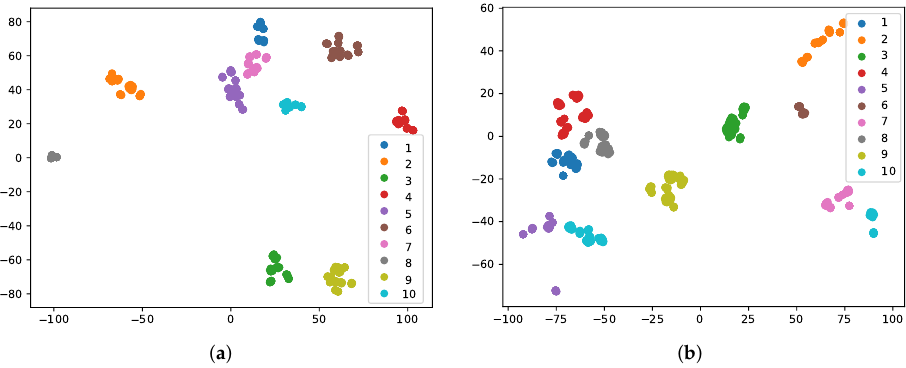
Figure 7. The t-SNE visualization for the features ( a ) proposed method features and ( b ) “GEI + ResNet50TP + L2” features on the testing set. Each color represents an identity and the features of every person are extracted from samples under “BG”, “CL”, and “NM” three